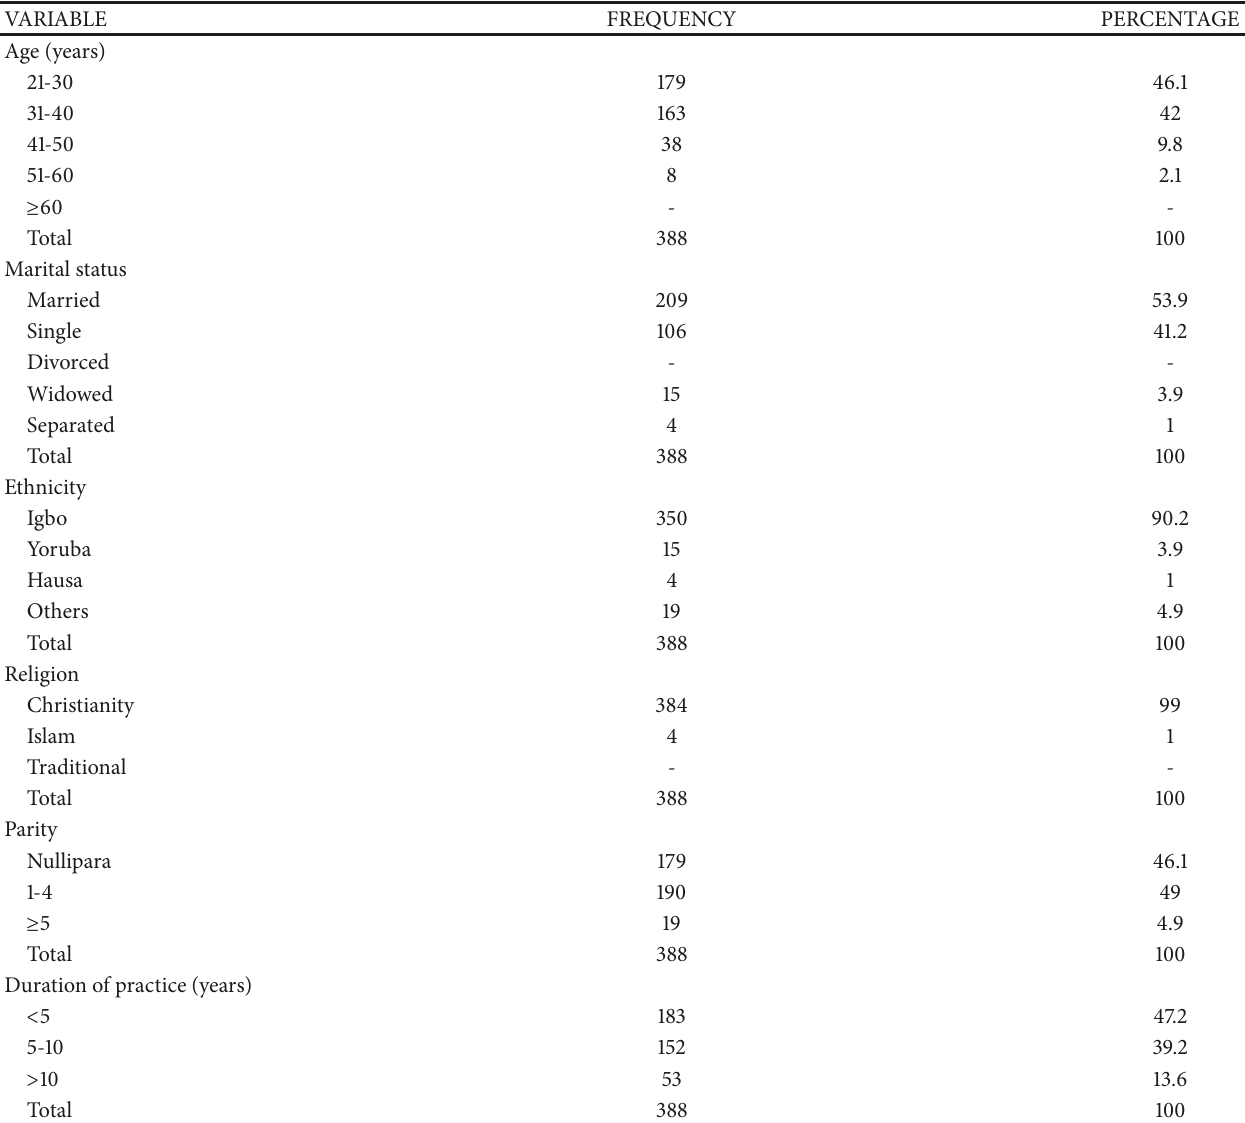
Table 1: Sociodemographic characteristics of study